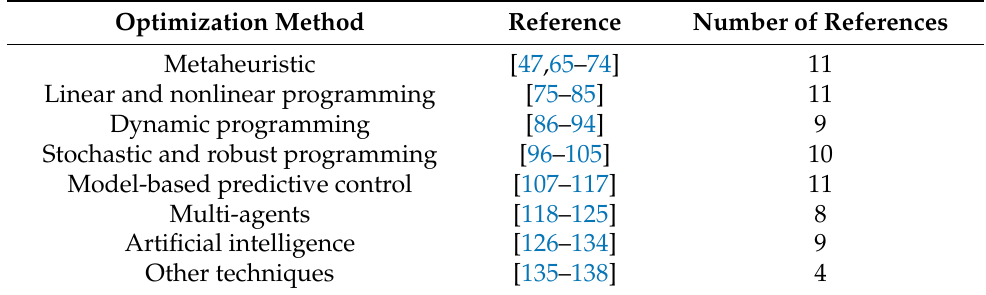
Table 2. Summary of the optimization methods for energy management in MGs.